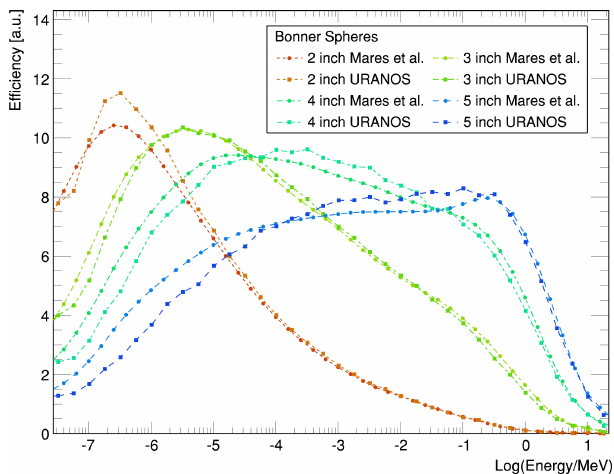
Figure 14. Energy-dependent neutron flux at a 1m altitude calcu- lated by PARMA, MCNPX, and GEANT4 and determined exper- imentally from Goldhagen et al. (2002) and from Federico et al. (2010). Environmental conditions are not the same (Pazianotto et al., 2015).